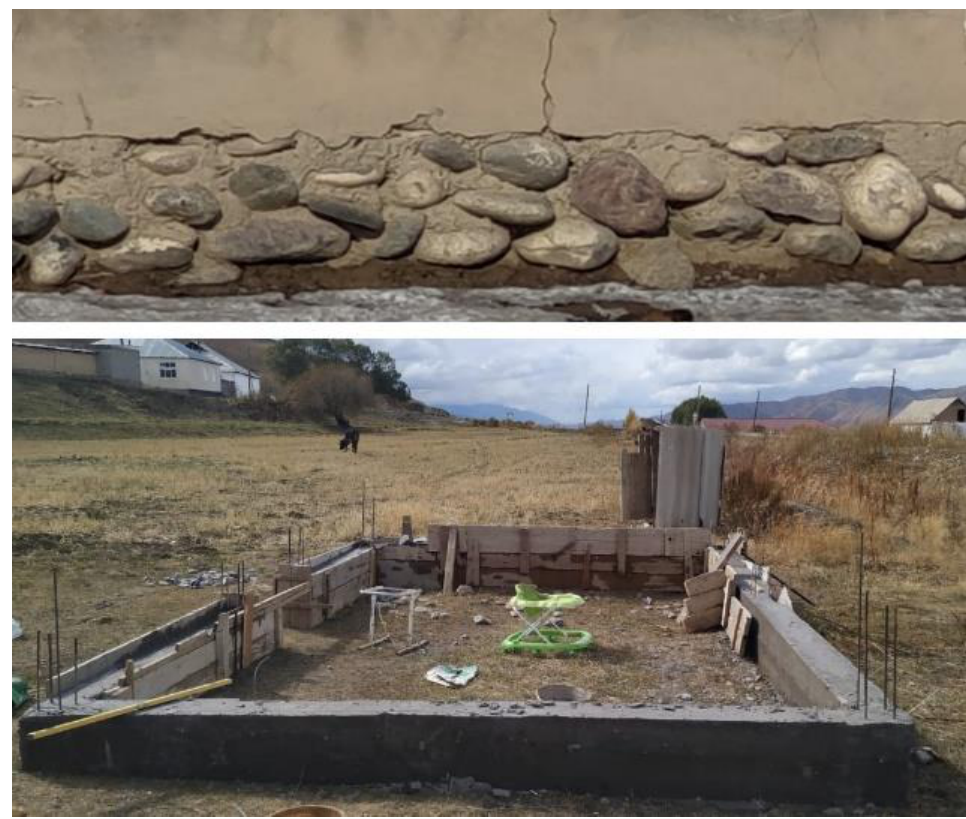
Figure 8. Foundation with the stone ( top ) and foundation with the concrete frame ( bottom ).